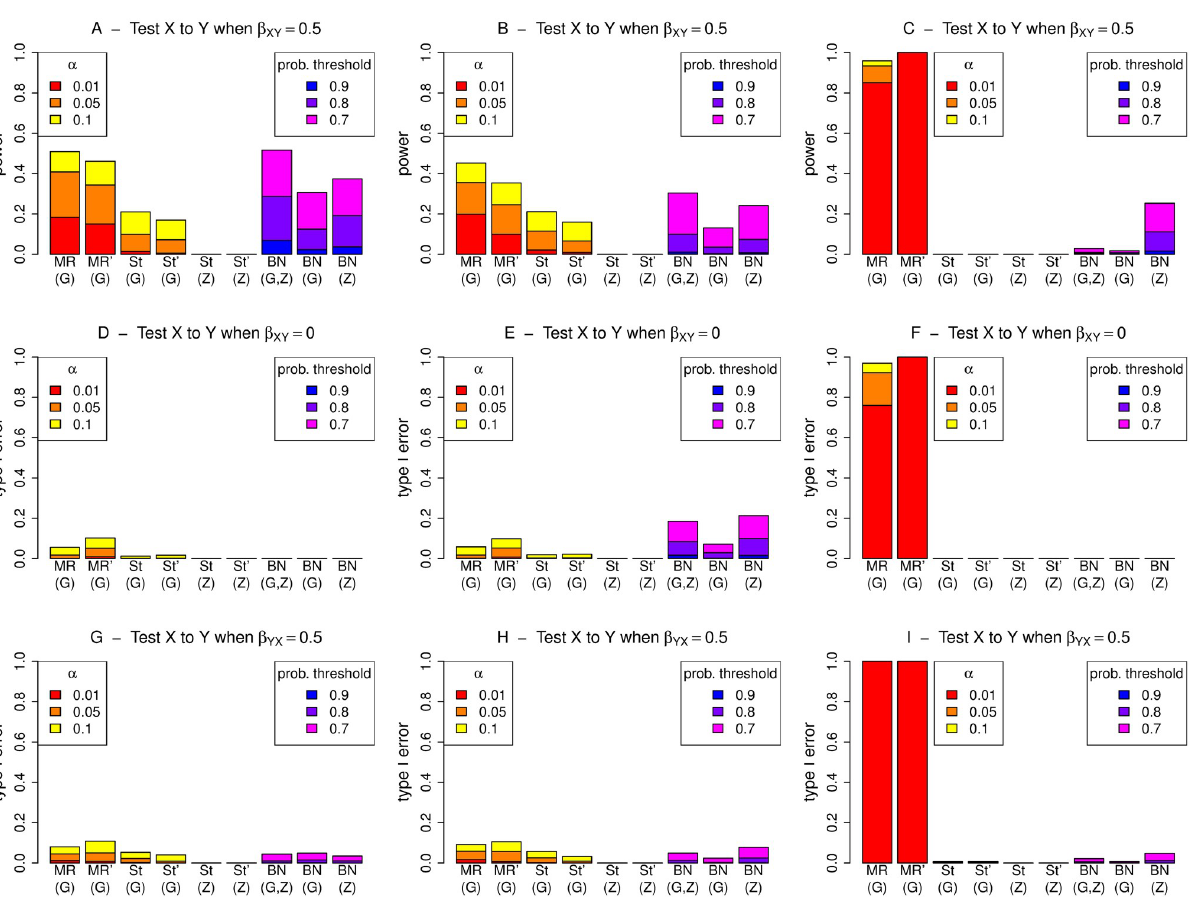
Fig 4. Performance (power and type I error) of different methods for detecting an edge from X to Y, under different generating scenarios that include strong confounding. MR and St denote MR and MR Steiger respectively, performed using instrumental variable regression which takes into account the uncertainty of the predicted values in the first-stage regression to calculate the MR p -values. MR’ and St’ denote MR and MR Steiger respectively, performed using two-stage least squares regression without accounting for the uncertainty of the predicted values in the first-stage regression. Left hand plots (A, D, G) are generated under model 1 (no confounding), middle plots (B, E, H) are generated under model 2 (non-genetic confounding), and right hand plots (C, F, I) are generated under model 3 (genetic confounding).